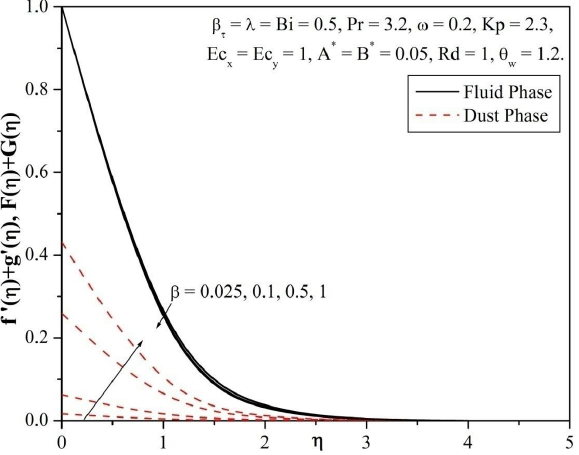
Fig. 11: Dimensionless temperature profiles for different values of B *